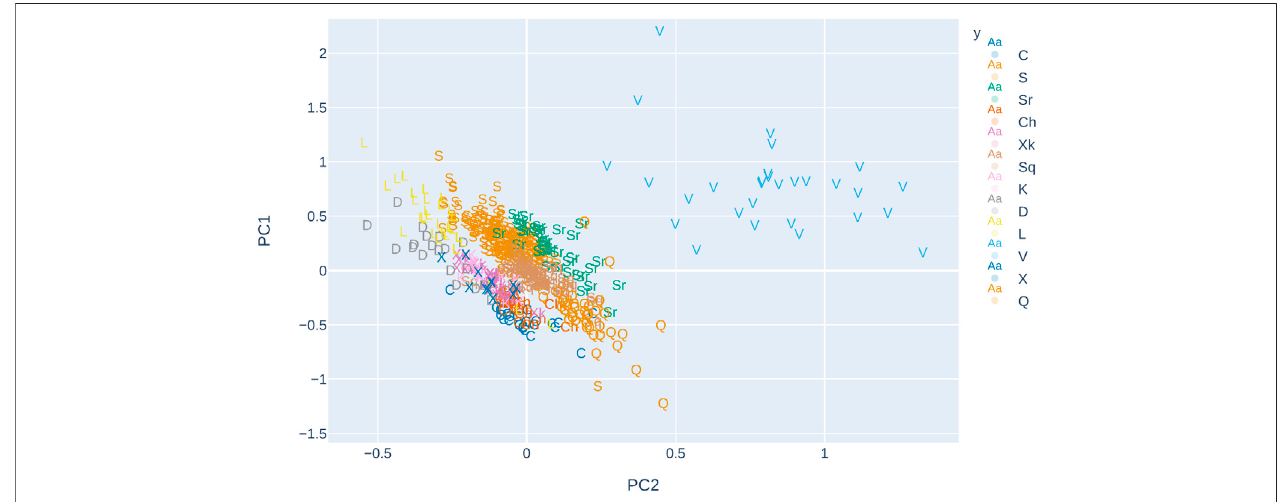
FIGURE 1 | Plot represents the two main principal components of the spectra, the letters denote taxonomic types, and colors denote the complexes.